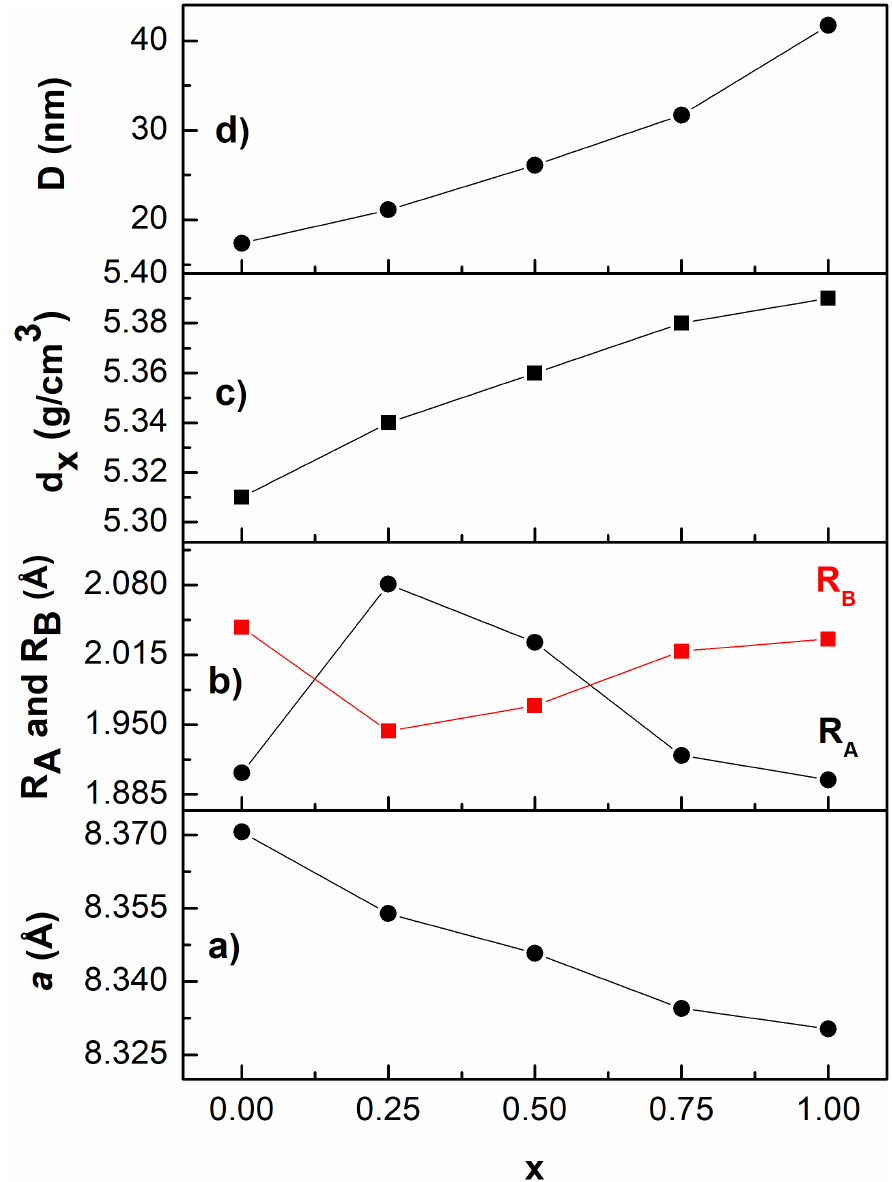
Figure 3. Variation of some structural quantities as a function of Ni content: ( a ) lattice constant, ( b ) the average bond lengths of R A and R B , ( c ) the X-ray density, and ( d ) the crystallite